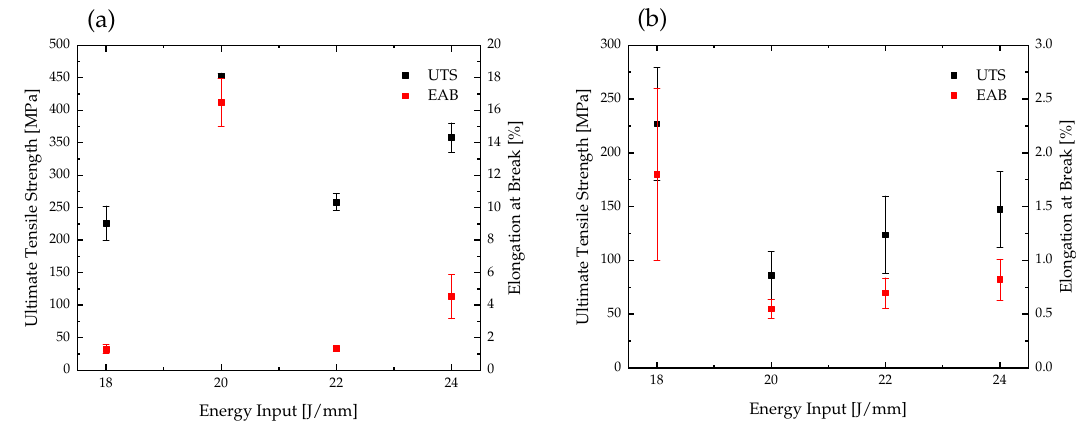
Figure 14. Mean values and SEM of ultimate tensile strength and elongation at break for AISI430Ti after ( a ) 10h and ( b ) 20h of exposure to the corrosive environment, calculated from five tensile tests.